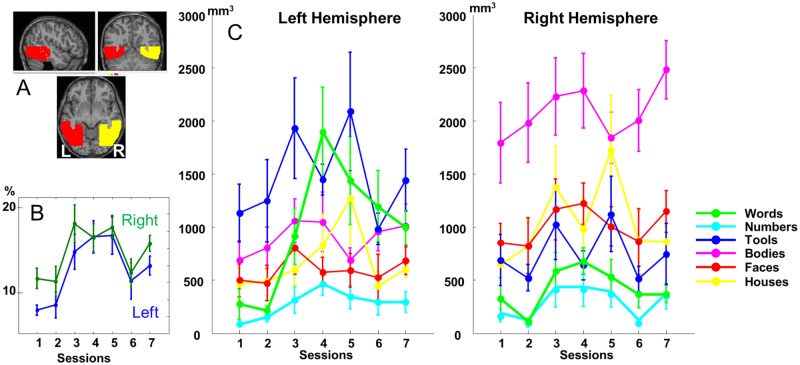
Evolution of the volume of activity evoked by the different categories in ventral visual cortex.(A) Slices showing the analyzed ventral visual region (“ventral mask”). (B) Percentage of voxels showing activity specific to at least 1 visual category (i.e., voxels whose activity was significant at p < .001 in the contrast of one category relative to all others). The active volume was expressed, in each child, as a proportion of ventral visual volume (i.e., the intersection of each child’s gray matter mask and the left and right ventral masks). (C) total volume (in mm3) of voxels showing significantly more activity for a given category relative to all others (voxelwise p < 0.001, uncorrected). For reference, the search regions were 36,080 mm3 (left) and 35,896 mm3 (right), and the volume expected by chance would therefore be approximately 36 mm3. S2 Data.